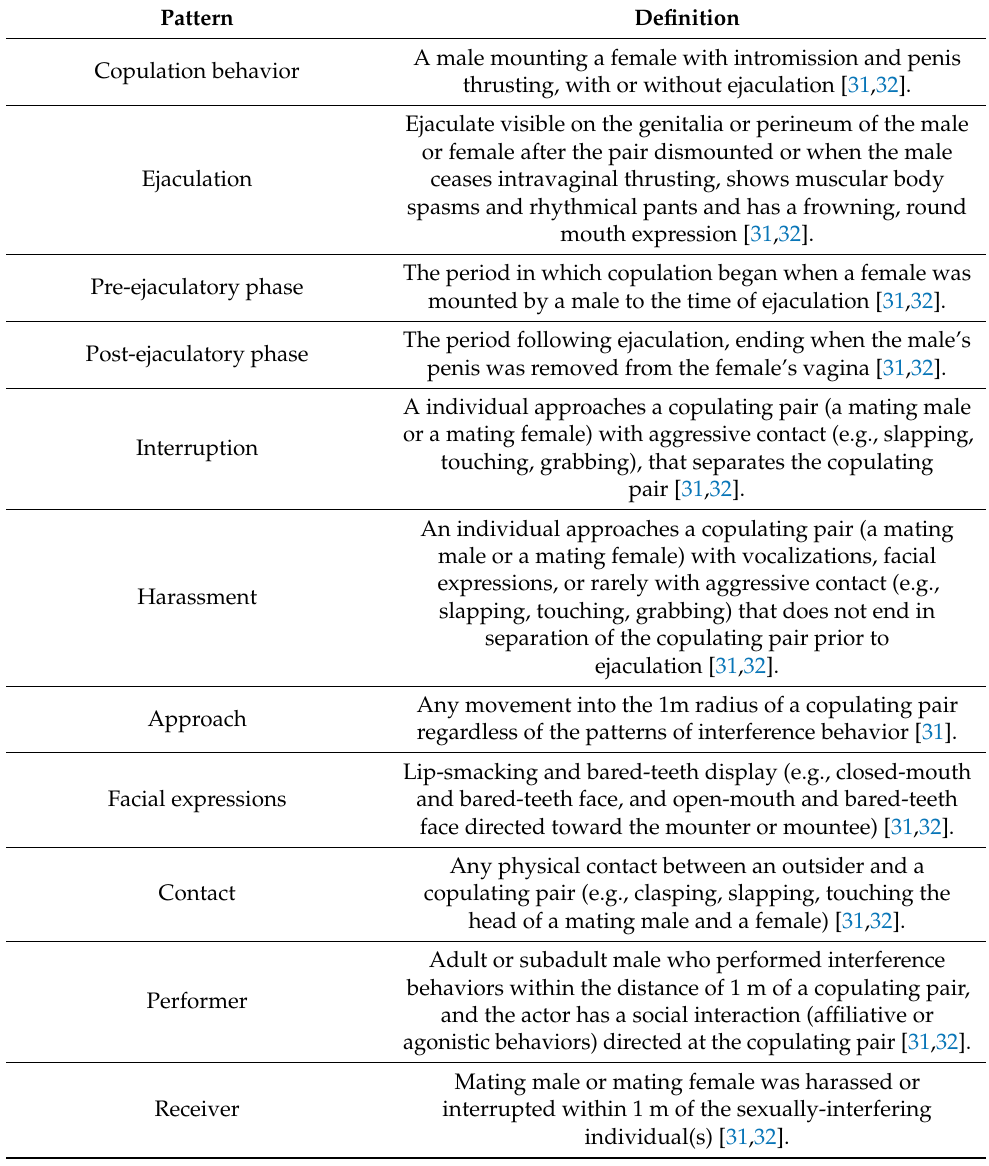
Table 2. Description of the pattern of interference in Tibetan